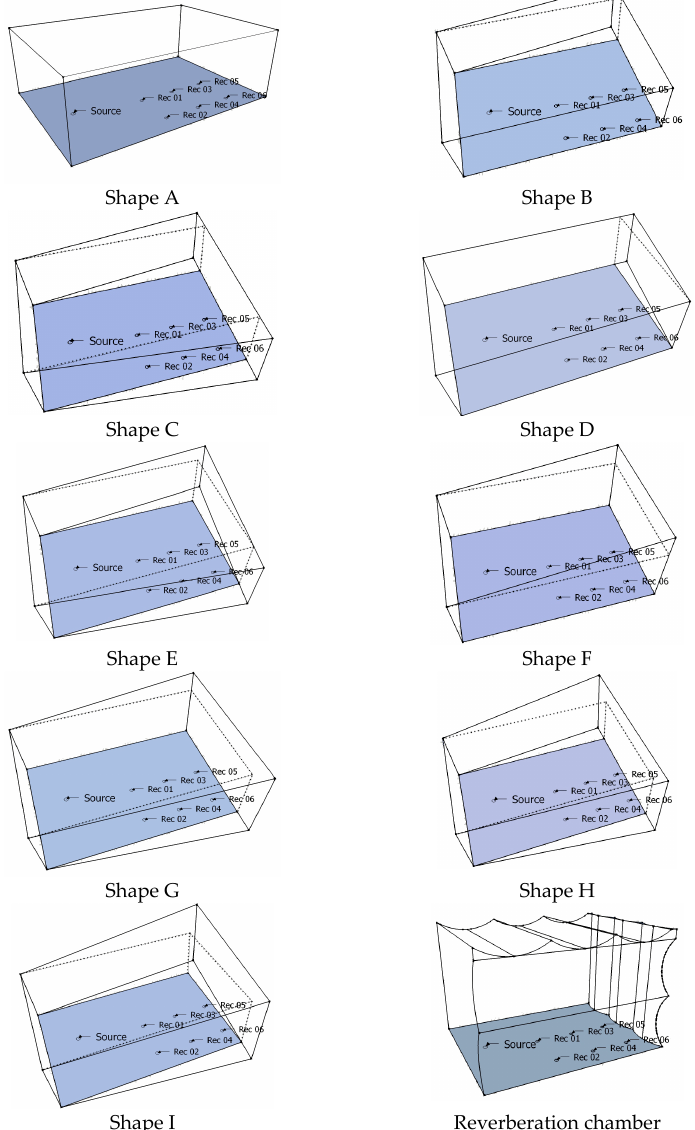
Figure 1. Ten spaces used for simulated calculations. The blue area is the bottom of the reference rectangle. The dotted and solid lines represent the rectangular and adjusted spatial shapes, respectively.